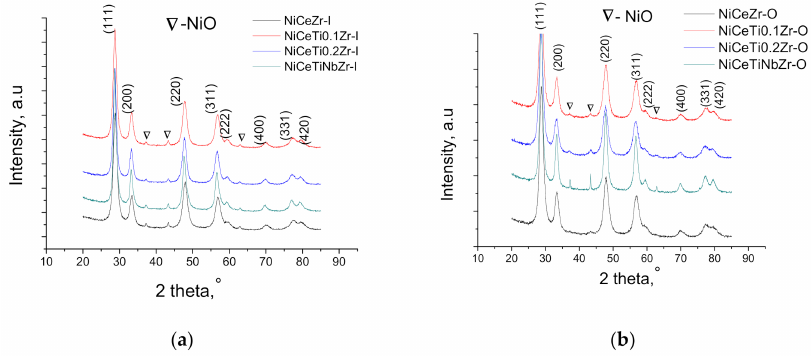
Figure 1. X-ray diffraction patterns obtained for impregnated ( a ) and one-pot ( b ) samples.